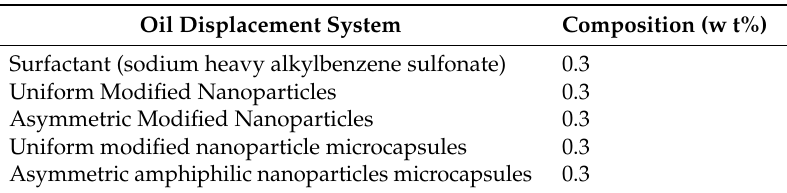
Table 1. Composition of five oil displacement systems.